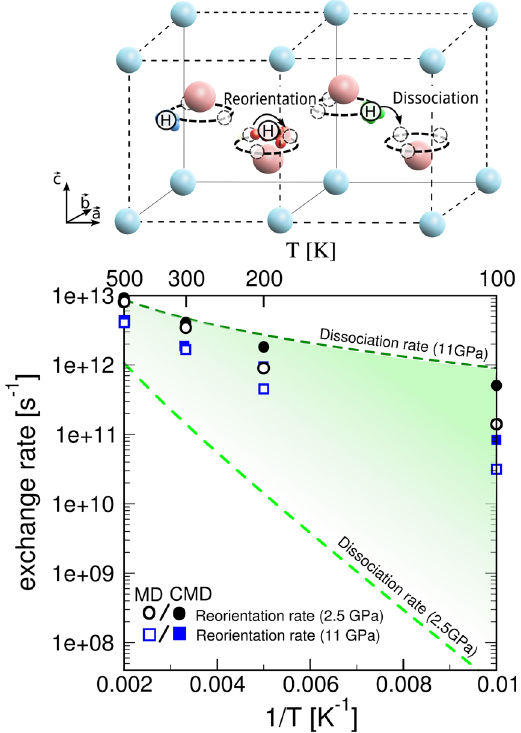
Figure 4. ( a ) Models of two processes involved in the global transport of H atoms within layers under pressure. “Reorientation” corresponds to jumps around O between two disordered sites; “dissociation” refers to jumps of an H atom to the next O atom. ( b ) Kinetic rates versus temperature for a range of pressures. The reorientation of protons is given by symbols: empty for classical MD nuclei, and full for quantum CMD ones. The green zone indicates the rate of dissociation in the classical Eyring approximation up to high pressures. Note that reorientation becomes the slower process at high pressures, blocking proton transport between hydroxide